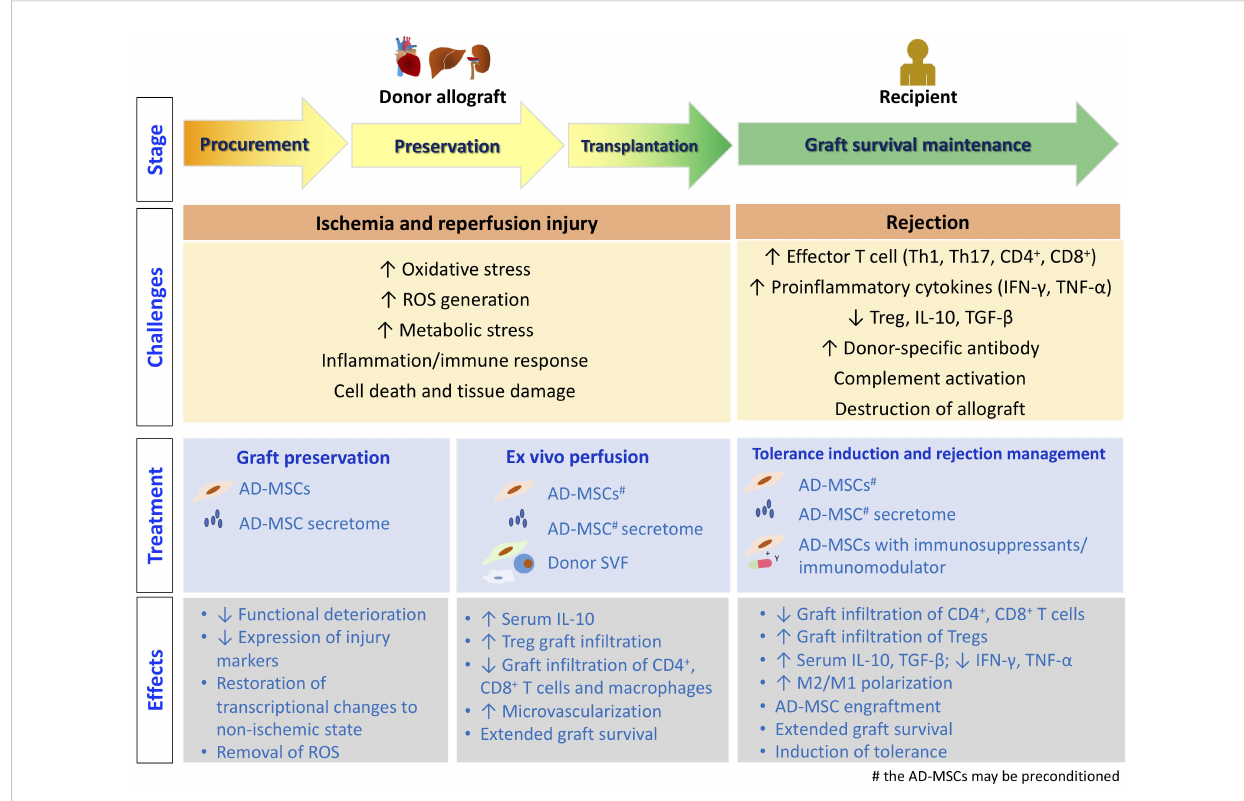
FIGURE 2 The stages of allotransplantation. The challenges encountered at each stage, along with the treatment strategies employing adipose tissue-derived therapeutics, are depicted. Additionally, the underlying molecular and cellular events are